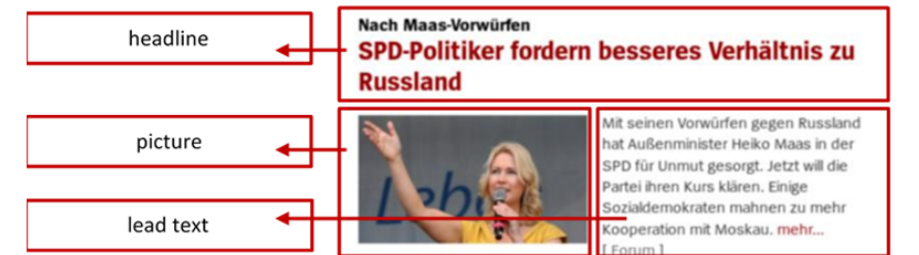
Figure 3. Structure of website teaser: Units of analysis. a sub-index. The sub-indices from all sub-dimensions were then again averaged into an overall index. Again, the values of this index range from 0 (no features at all; not softened at all) to 1 (all features used to the greatest possible extent; completely softened).